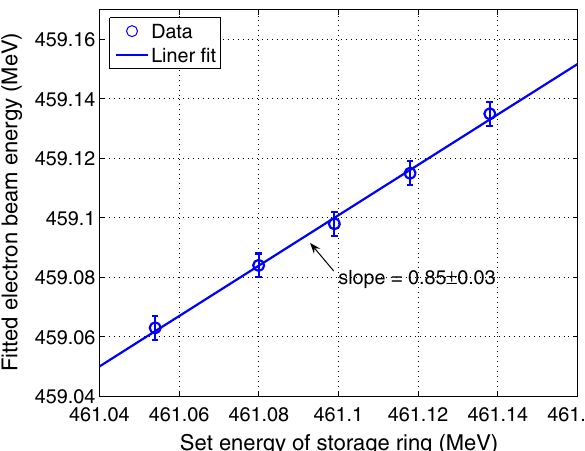
FIG. 12. (Color) Electron beam energy determined by Eq. (16) as a function of the set energy of the storage ring. The set energy has been corrected according to the digital-to-analog converter value which controls a power supply of dipole magnets. The vertical error bars only represent the statistical errors of the electron beam energy measurement, excluding the systematic errors. The straight line is the linear fit of the determined electron beam energies. The slope of the fit line as well as the fitting error associated with it are also shown in the